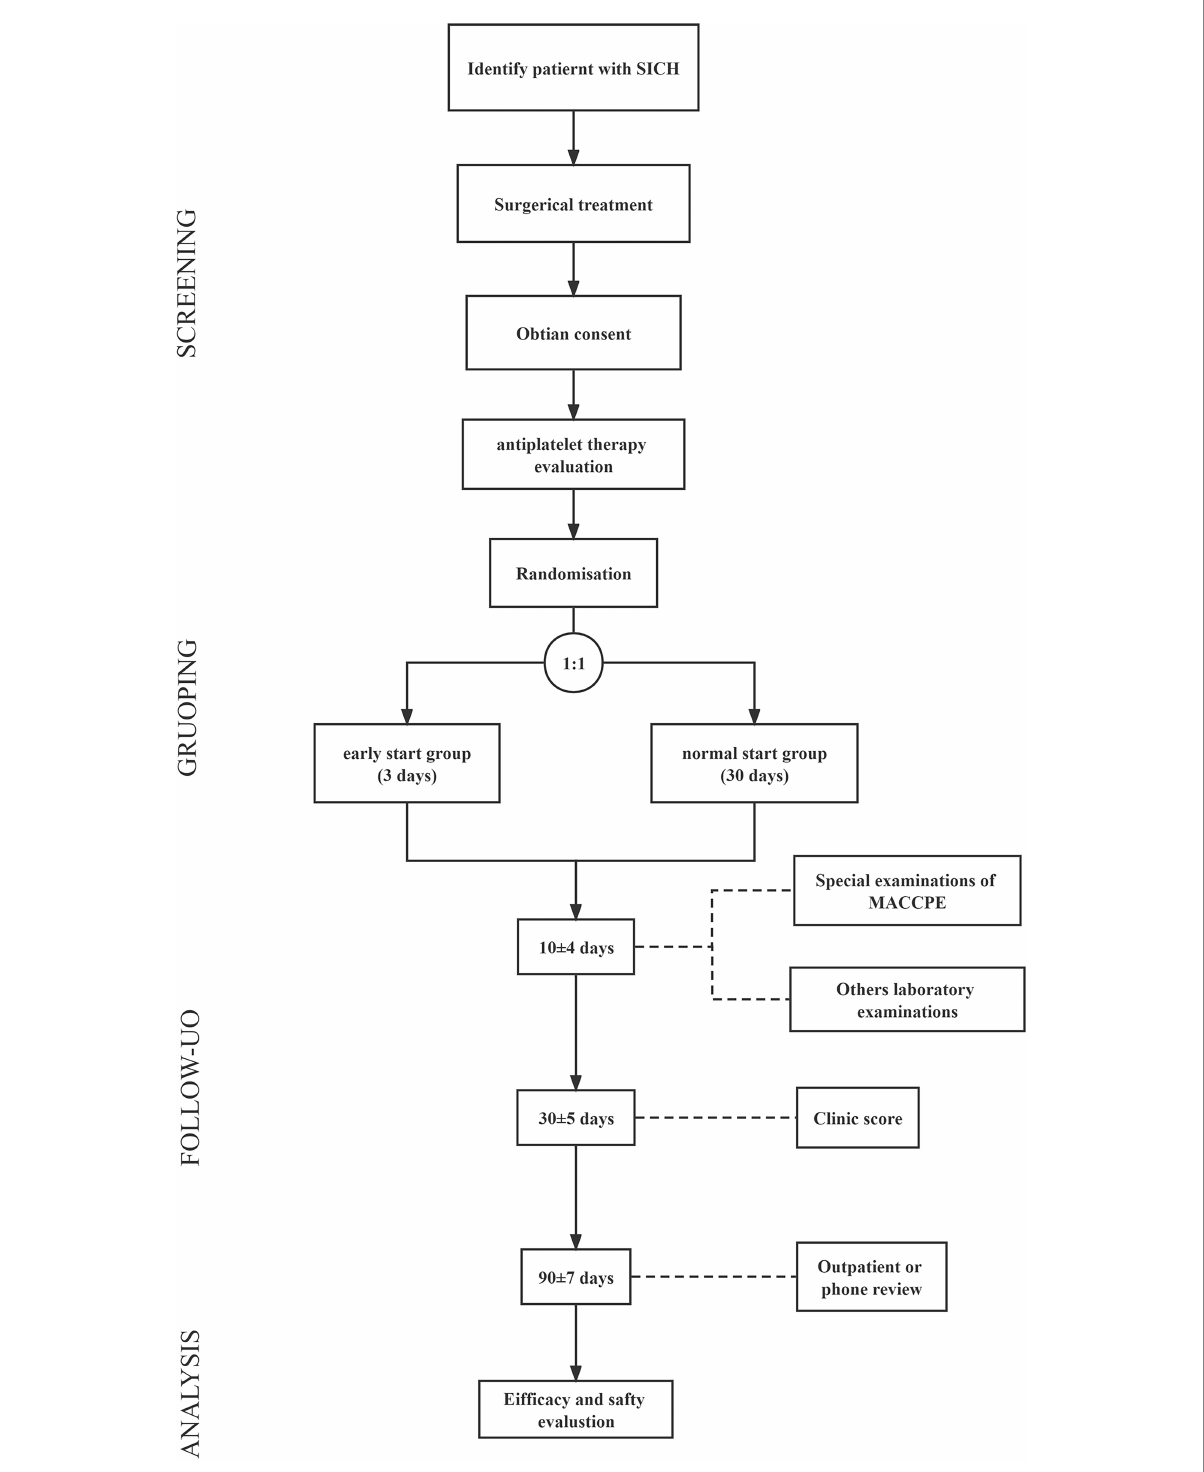
FIGURE 1 The flowchart of study